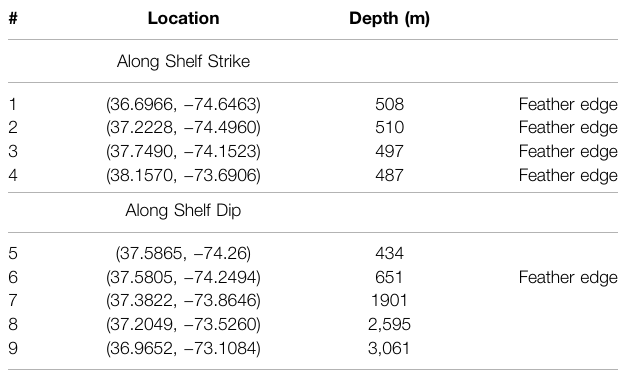
TABLE 2 | Locations picked for PFLOTRAN/Dakota